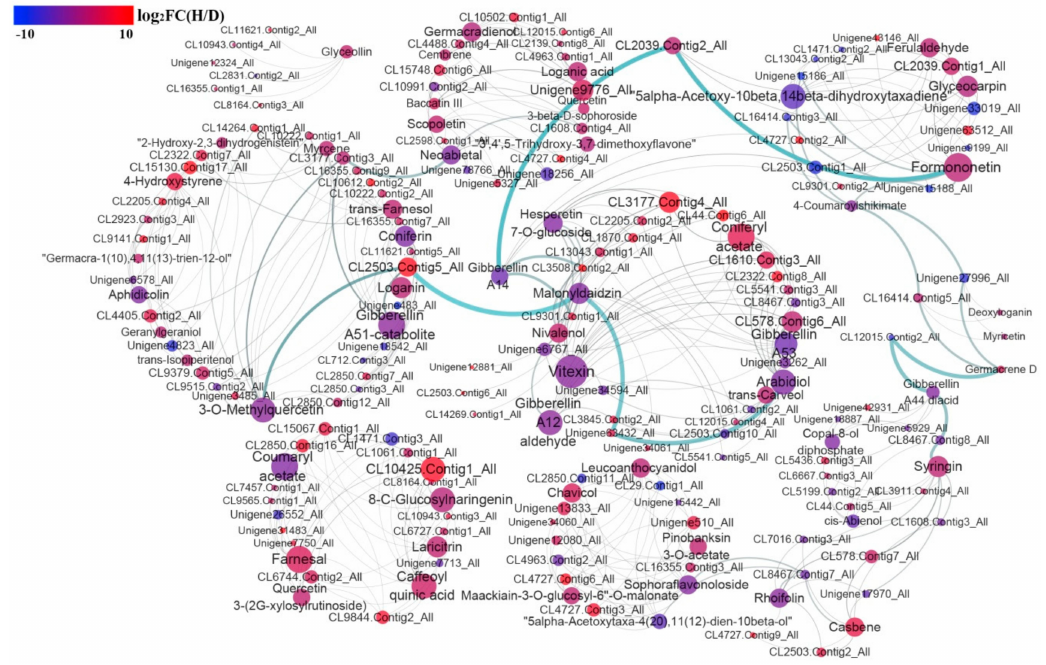
Figure 7. The regulation of DEGs involved di ff erentially accumulated metabolites synthesis network. The color bar represents the log 2 transformed fold change value of hexaploid compared with diploid. The red represents higher fold change value, and blue represent lower fold change value. The bubble size that based on the connect degree and the width of connect lines that based on edge betweenness was represent the important of nodes for DEGs or di ff erentially accumulated metabolites. Greater bubble size or connecting line thickness represent more important